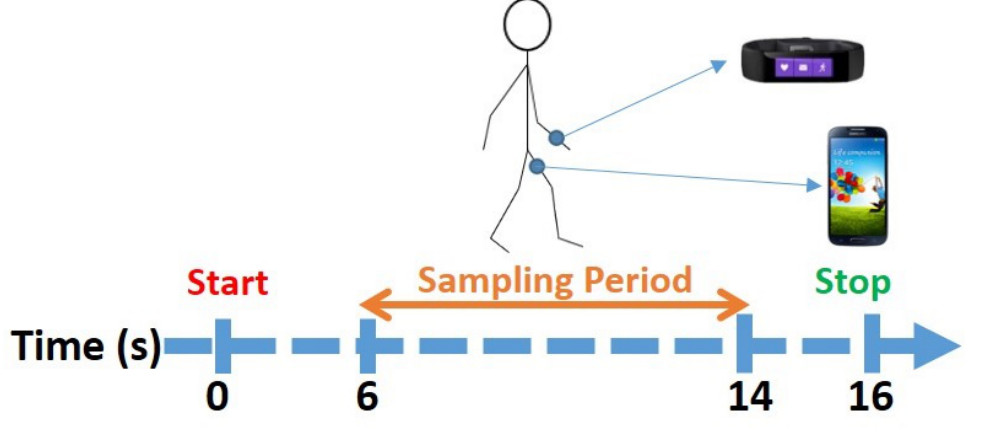
Figure 1. Experimental protocol: a sample of eight seconds of motion sensor data obtained when the subject was